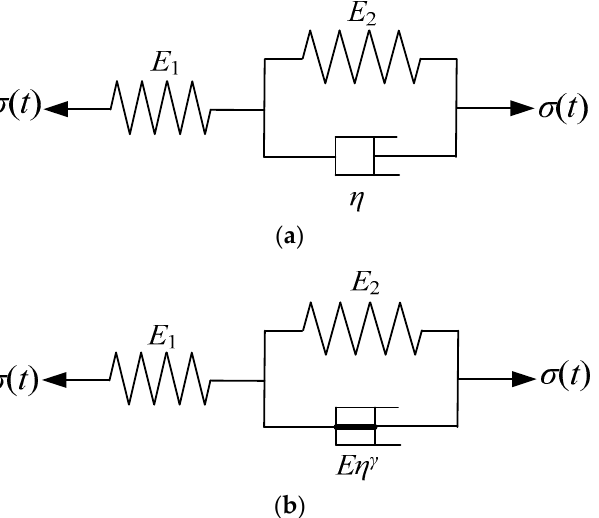
Figure 2. The three-parameter solid model. ( a ) The integer-order three-parameter solid model, ( b ) The distributed order three-parameter solid